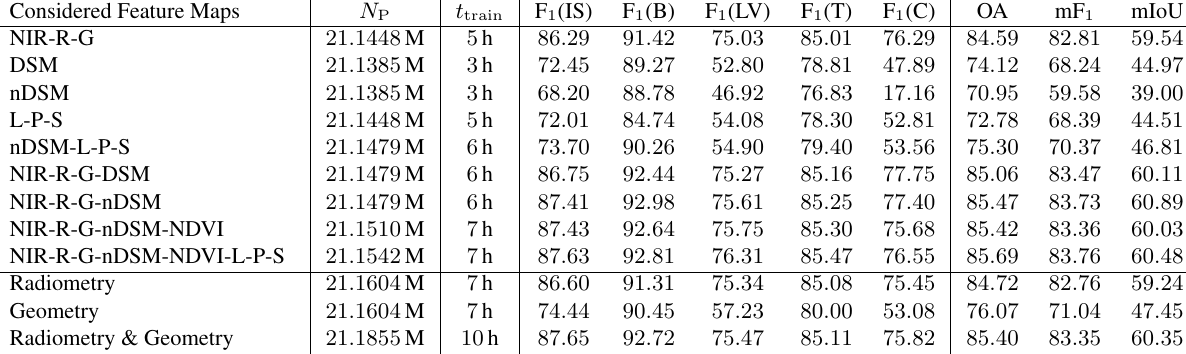
Table 1. Number of parameters N P , training time t train and derived classification results for different subsets of the defined feature maps serving as input to the RSCNN: the F 1 -scores and the values for OA, mF 1 and mIoU are given in % and the classes are abbreviated